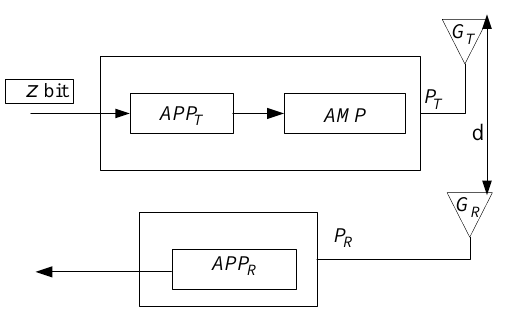
Figure 5. Block diagram of the transmission system.